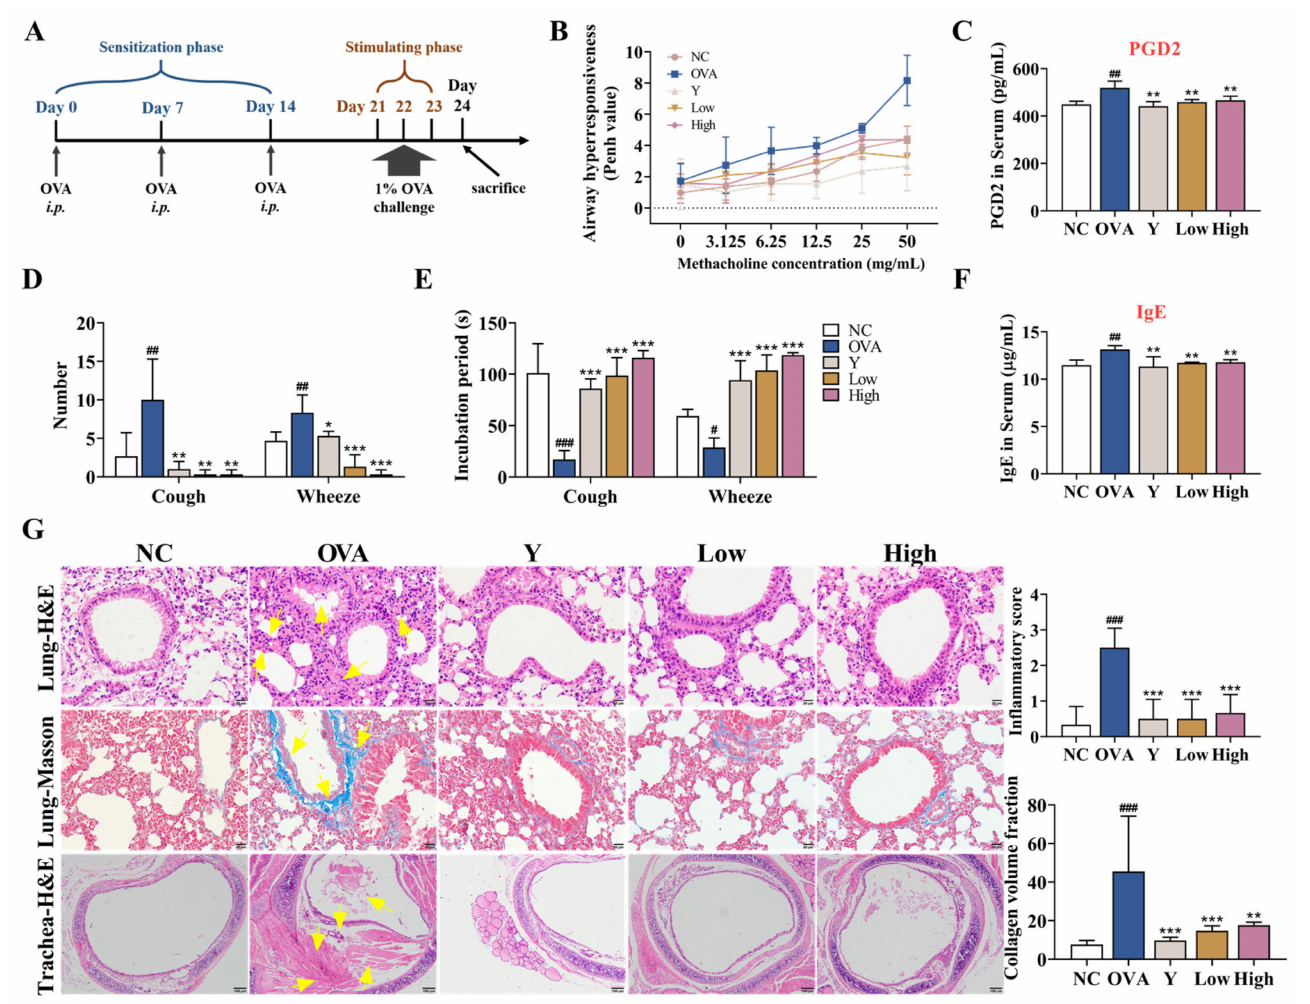
Figure 2. EB-A ameliorates asthma features on a mouse model of asthma. ( A ) Schematic repre- sentation of a mouse model of OVA-induced allergic asthma. The “ i.p. ” stands for intraperitoneal injection. ( B ) Airway hyperresponsiveness was measured as methacholine-induced increases in transpulmonary resistance in mice. Data are expressed as a mean value of percentage increased from the baseline of the transpulmonary resistance ± SD values of three mice (white or flesh pink: NC, peacock blue: OVA, powder blue: Y, lawn green: Low, chartreuse: High). ( C ) Serum PGD2 levels were measured using ELISA. ( D , E ) Twenty-four hours after the last administration, the number and incubation period of the cough and wheeze indexes were detected in the mice. ( F ) Serum IgE levels were measured using ELISA. ( G ) HE and Masson staining was performed, and then the inflammation intensity and collagen fiber area were scored. The yellow arrow indicates the lesion (400 × or 100 × ). All data are shown as mean ± SD. # p < 0.05, ## p < 0.01, ### p < 0.001, compared with the NC group; * p < 0.05, ** p < 0.01, *** p < 0.001, compared with the OVA